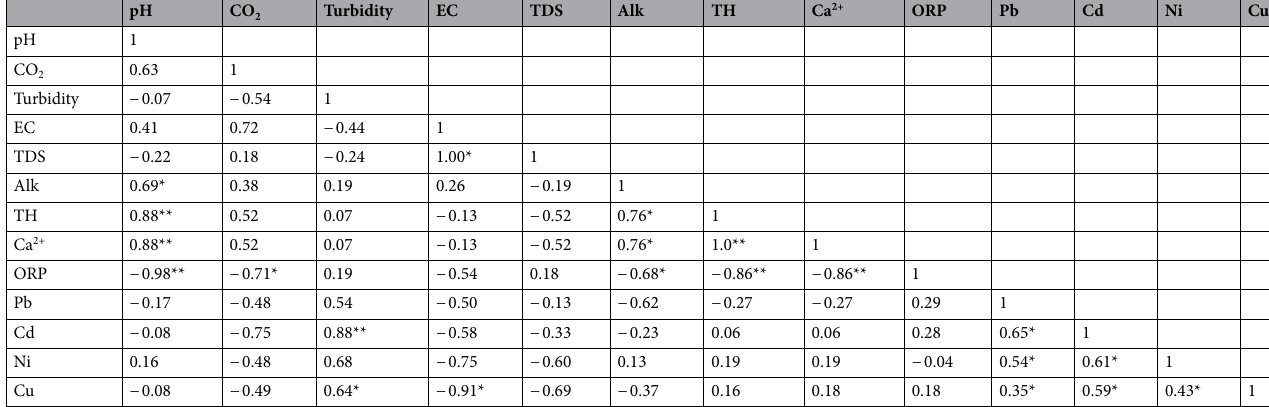
Table 4. Correlation coefficient matrix of water parameters. *Correlation is significant at the 0.05 level. **Correlation is significant at the 0.01 level.